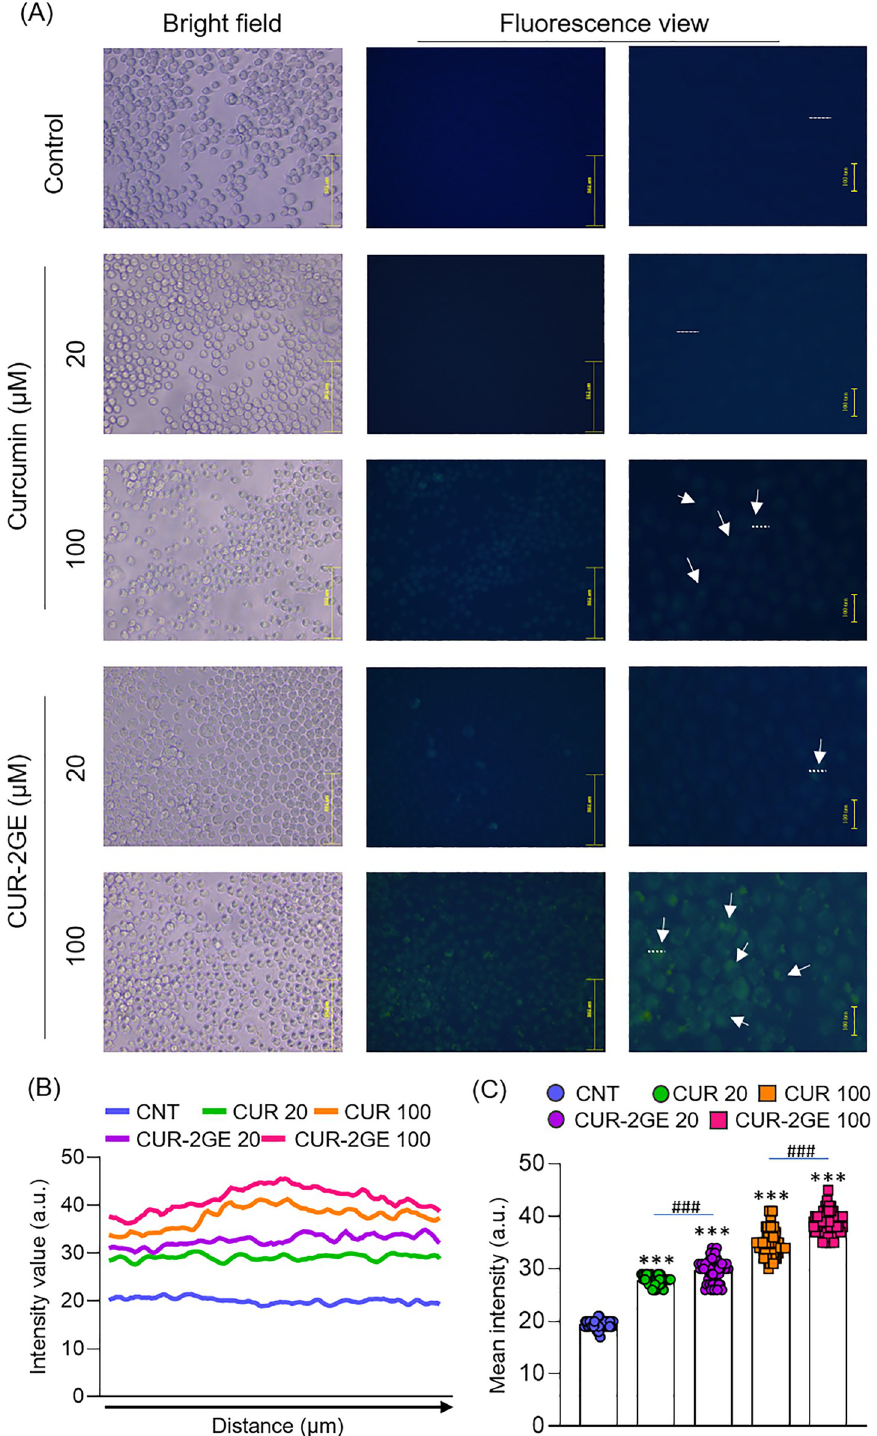
Fig 8. In vitro cellular uptake of curcumin and CUR-2GE. (A) Representative images of curcumin and CUR-2GE uptake in BV-2 microglial cells. The scale bars correspond to 502 μ m (center) and 100 μ m (right). The fluorescence intensity was further analyzed using ImageJ software. (B) Bar graph showing the fluorescent intensity of a single cell along the dotted line and (C) total average fluorescence intensity of 50 cells. The data in Fig 8C are expressed as mean ± SD (n = 50). ��� p < 0.001, control vs other treatments, ###p < 0.001, Curcumin vs CUR-2GE.